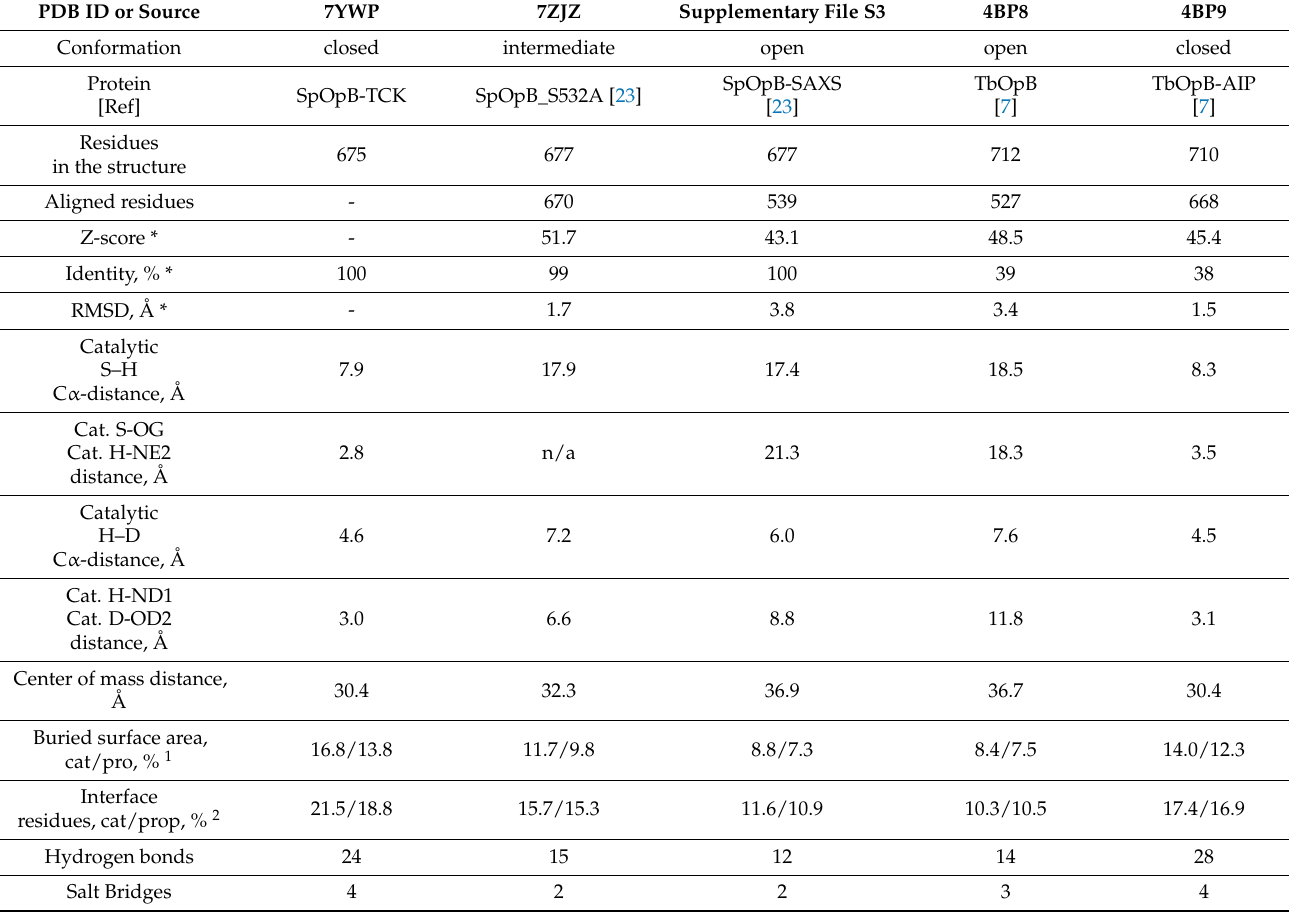
Table 1. Comparison of the mutual arrangement of the catalytic triad residues and domains in the crystal structure of SpOpB-TCK with those in different states of SpOpB and TbOpB. 7YWP 7ZJZ Supplementary File S3 4BP8